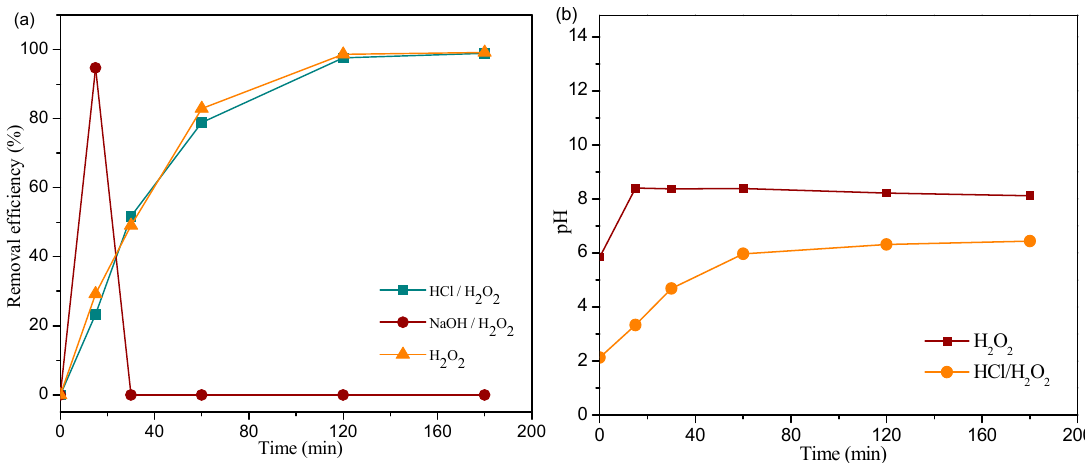
Figure 8. Influence о f the initial value о f pH solution on the rem о val efficiency о f MB (c 0 = 2.45 ∙ 10 − 2 mM) in the pres е nce of 29 tabl е ts of Fe 2 O 3(2) /TiO 2(1) /PVC composites and 13.1 mM H 2 O 2 at a stirring rat е of 490 rpm: ( a ) kinetic curve and ( b ) change in pH value during removal process under SSR.